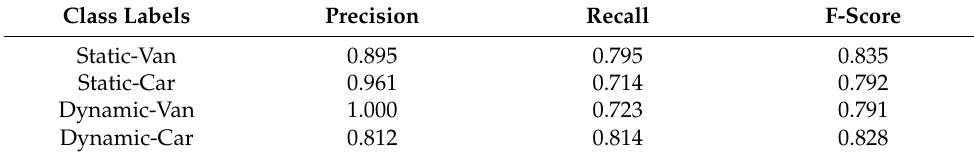
Table 7. Classification results of CIWHO-ORC technique under KITTI MOD dataset.